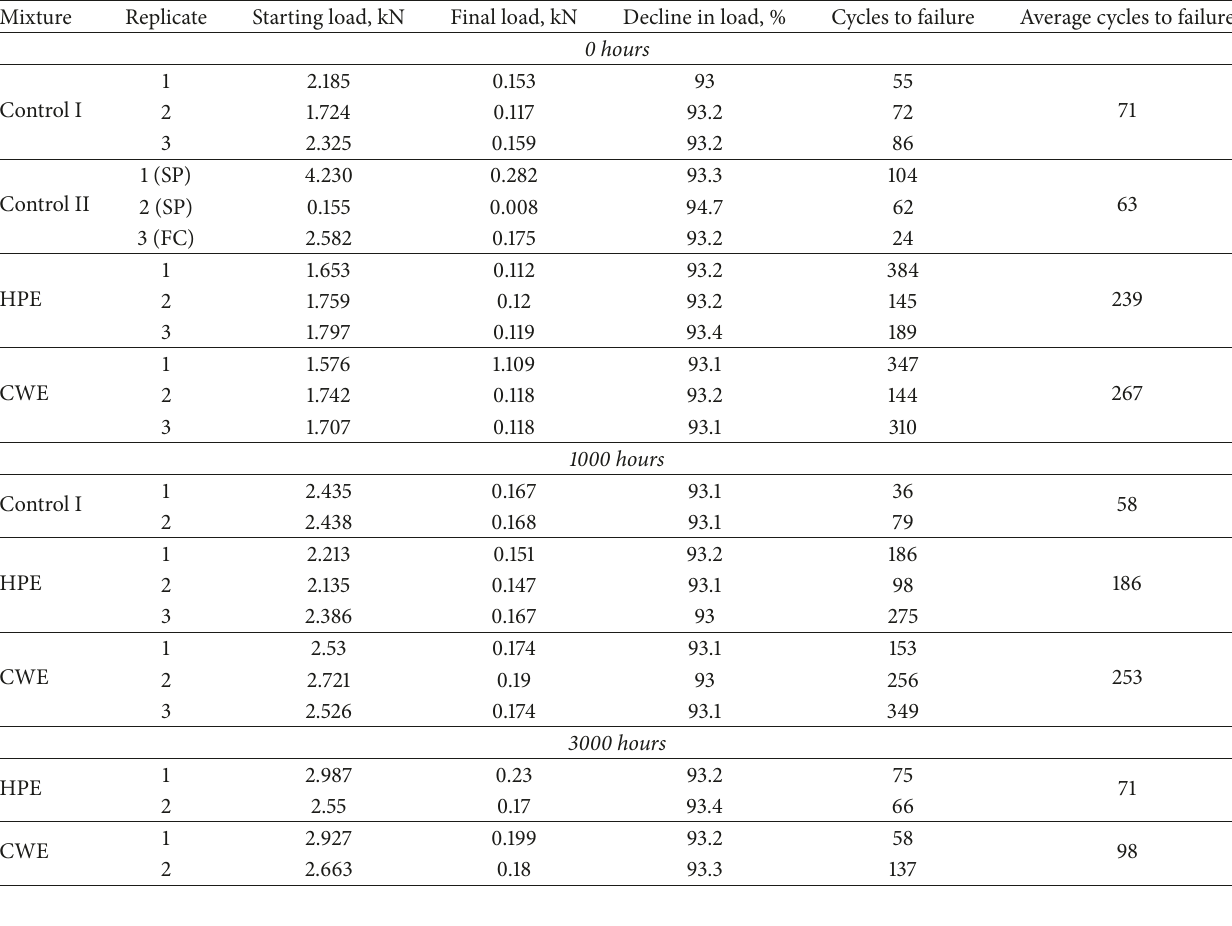
Table 5: Texas overlay test results before and after APWS aging.